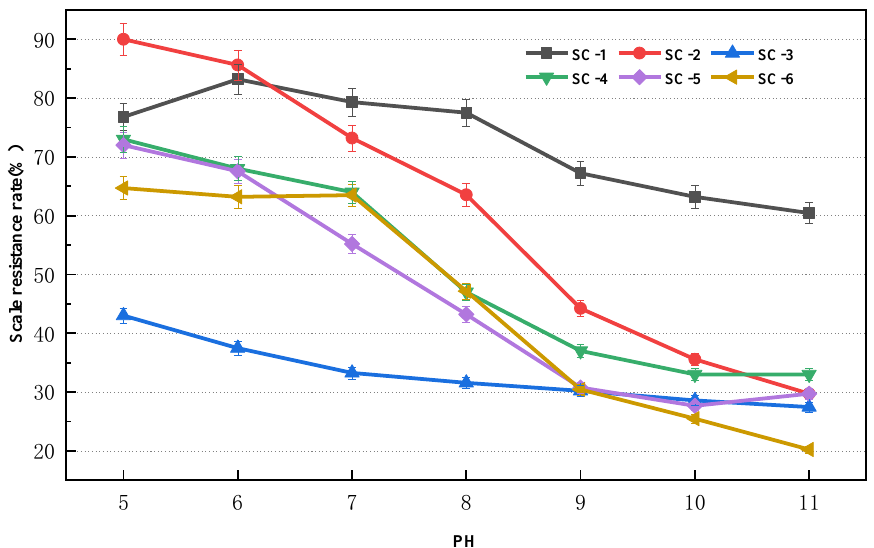
Figure 5. Effect of scale inhibitor on calcium carbonate at different pH levels and room tempera- ture.